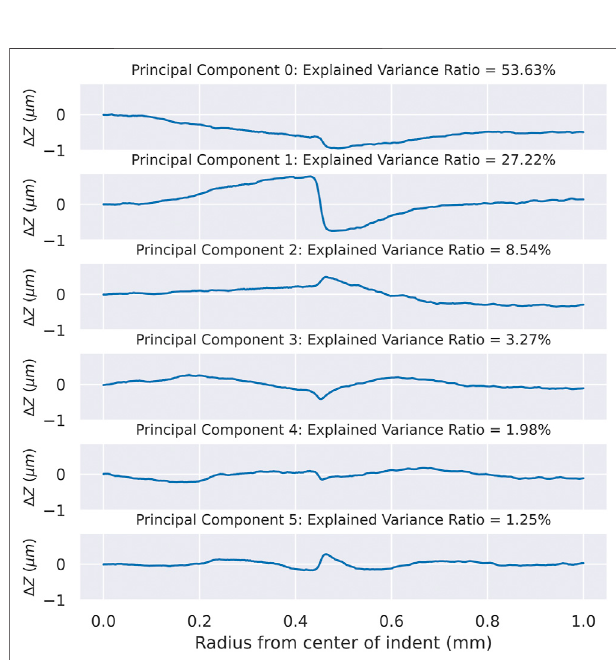
FIGURE 9 | The principal components used to approximate the random variations observed in the 84 experimentally measured indentation pro fi les, after noise fi ltering with a low pass fi